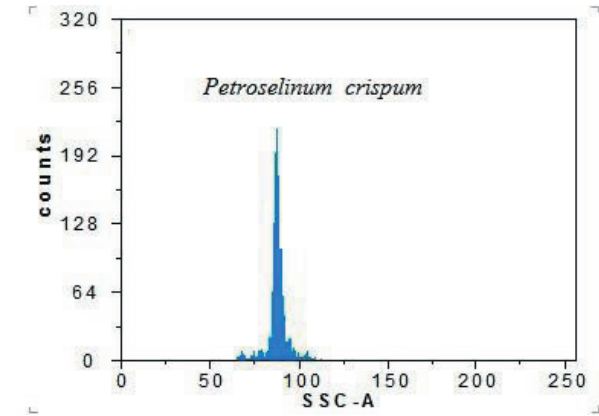
Figure 2. The histogram for analysis of the amount of nuclear DNA in leaves: parsley (P. crispum) reference standard (2C DNA=4.50